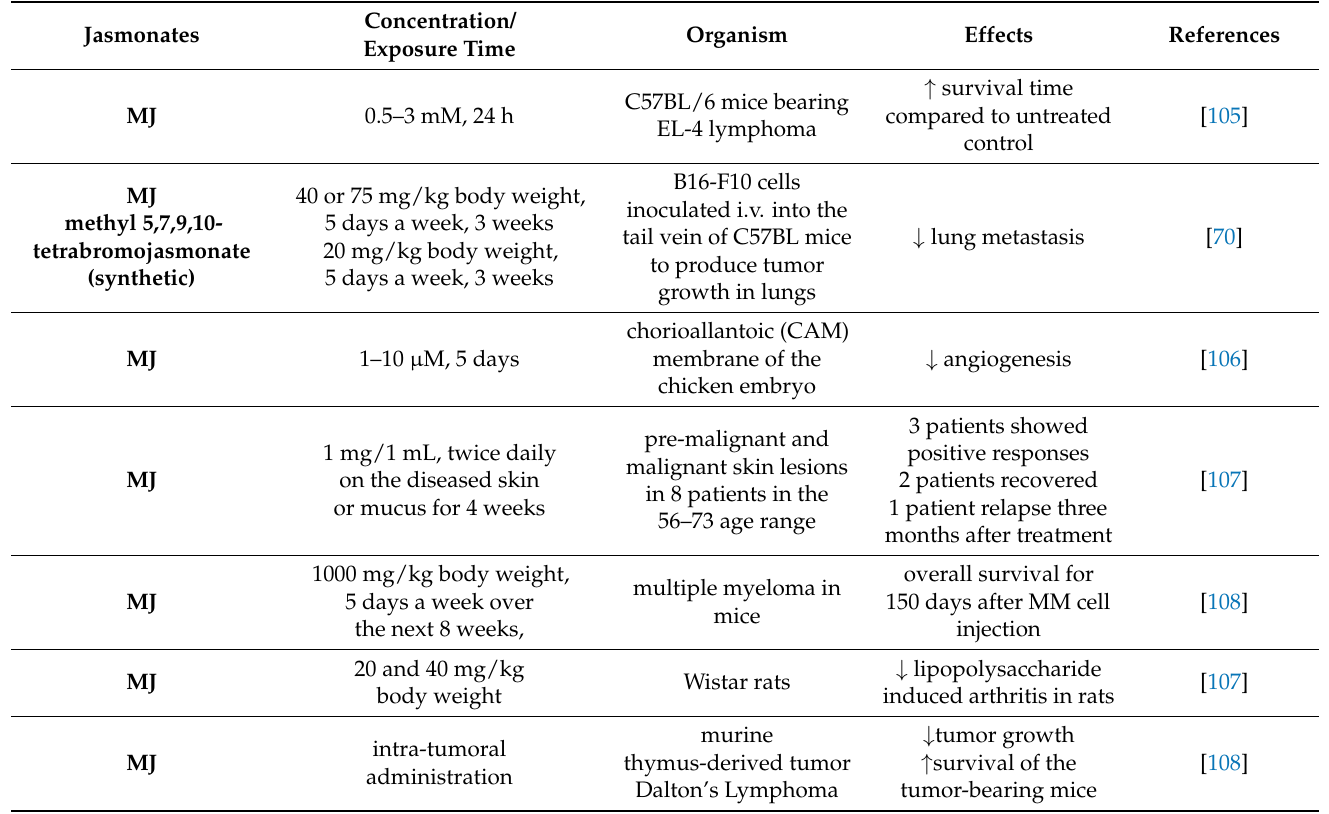
Table 4. In vivo effect of methyl jasmonate and synthetic